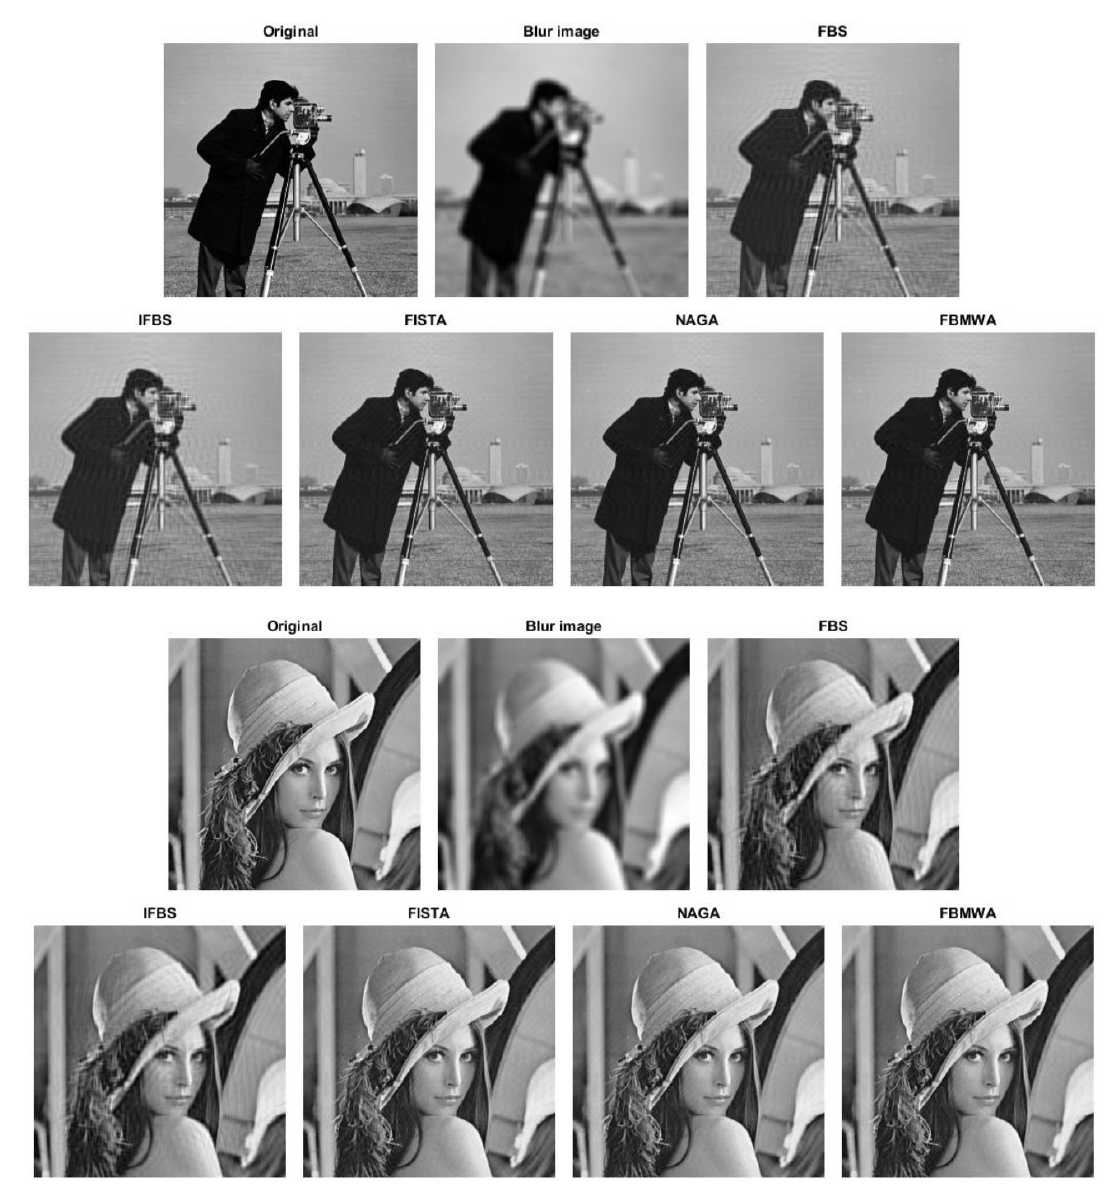
Figure 2. Results for deblurring of the Cameraman and